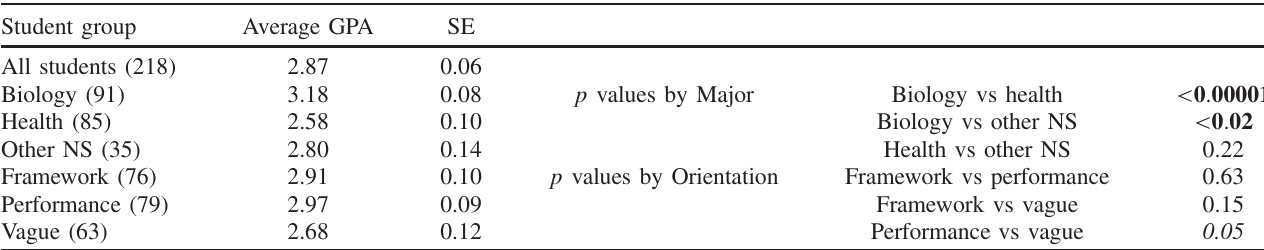
TABLE V. Average course grade for major groups, with standard error for each group and p values between groups. Student